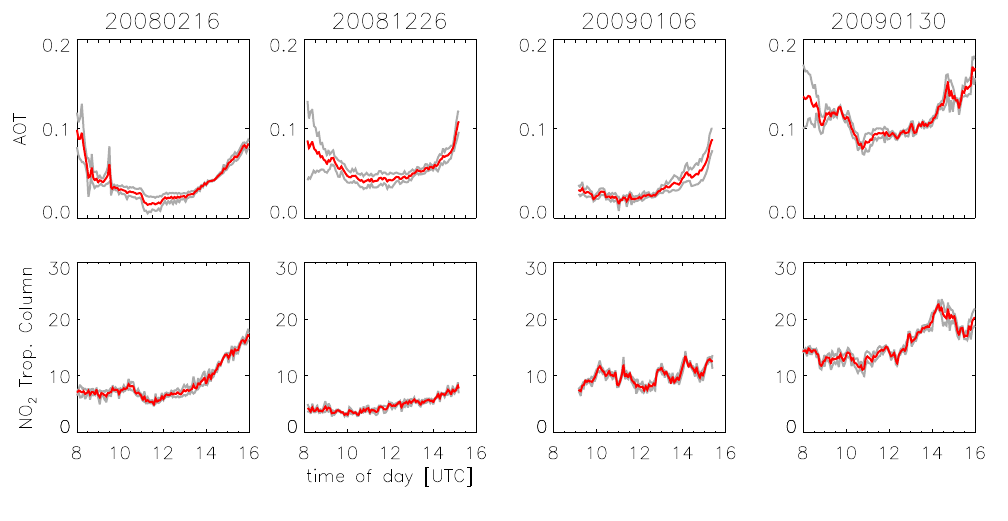
Fig. 11. Retrieved aerosol optical thickness (upper row) and tropospheric NO 2 column (lower row) for four selected days using the two-step algorithm. The red lines represent the average value of the three elevations: 4 ◦ , 8 ◦ , and 16 ◦ . The spread is indicated by the grey lines.